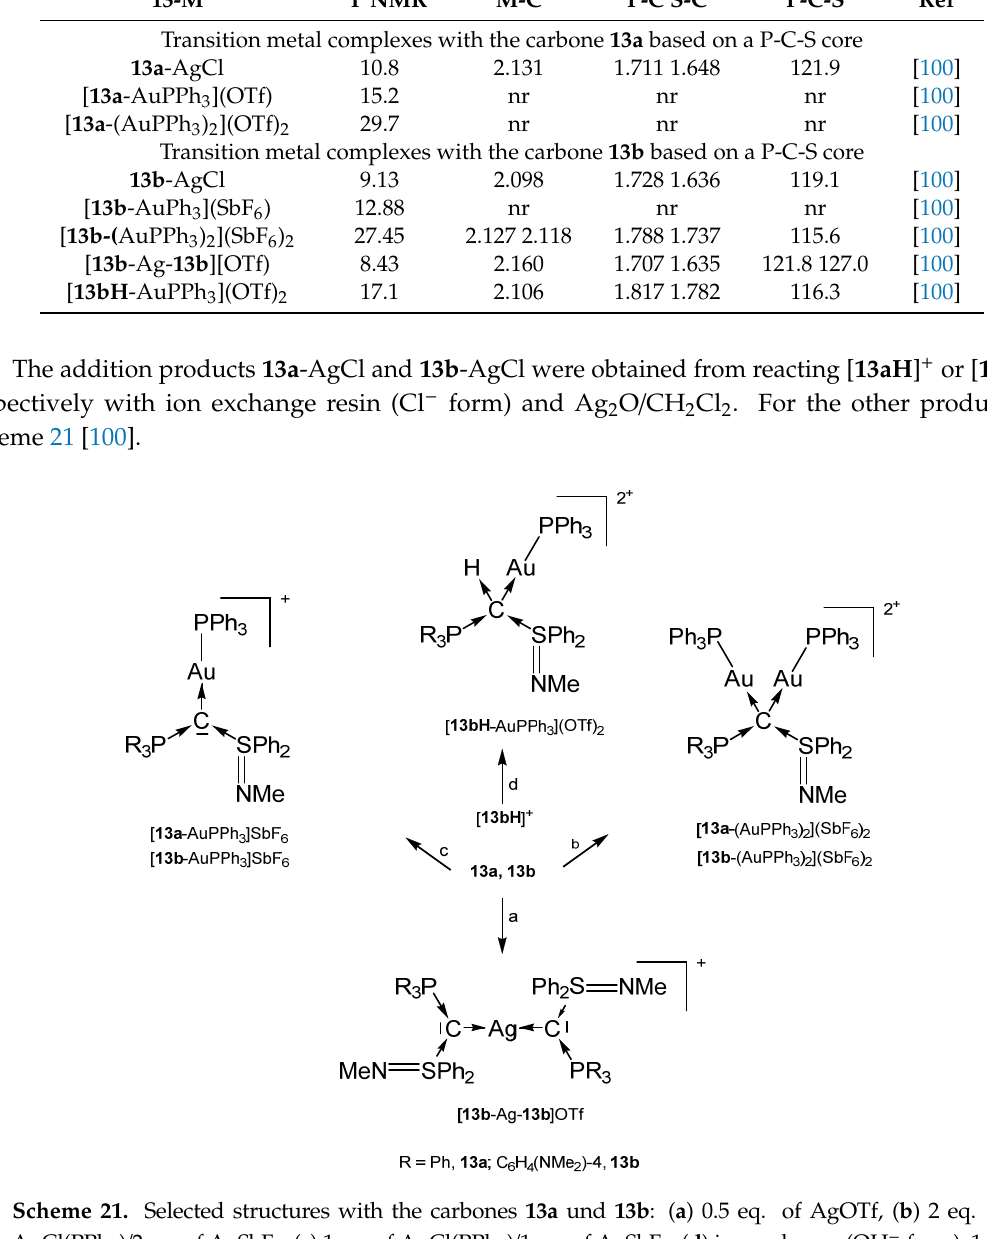
Table 11. Collection of transition metal complexes with the carbones 13a and 13b . 31 P NMR signals (in ppm) are given.